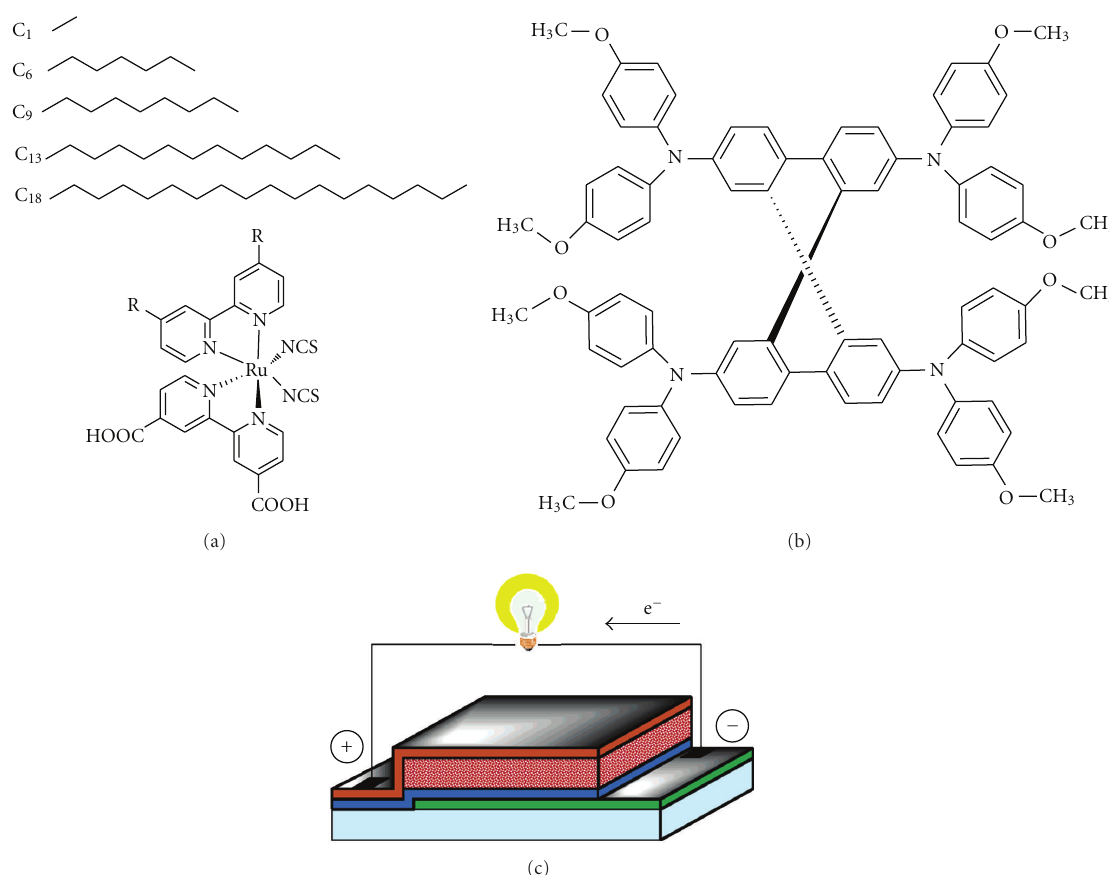
Figure 9: Molecular structures of the dyes with di ff erent chain lengths (a) and the hole conductor (b) used for the device preparation are shown next to a schematic of the device structure (c) the devices consist of a glass substrate covered by a conductive transparent electrode (F-doped SnO 2 ) (taken from [24]).